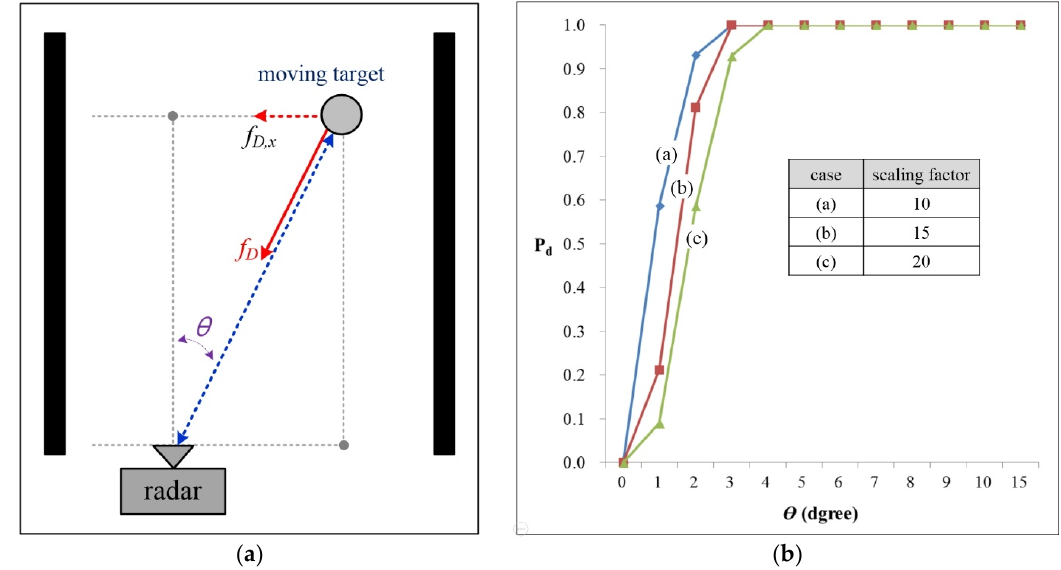
Figure 5. The detection probability of a moving target when varying the scaling factor for the angular position: ( a ) scenario considered for the worst case; and ( b ) simulation results.